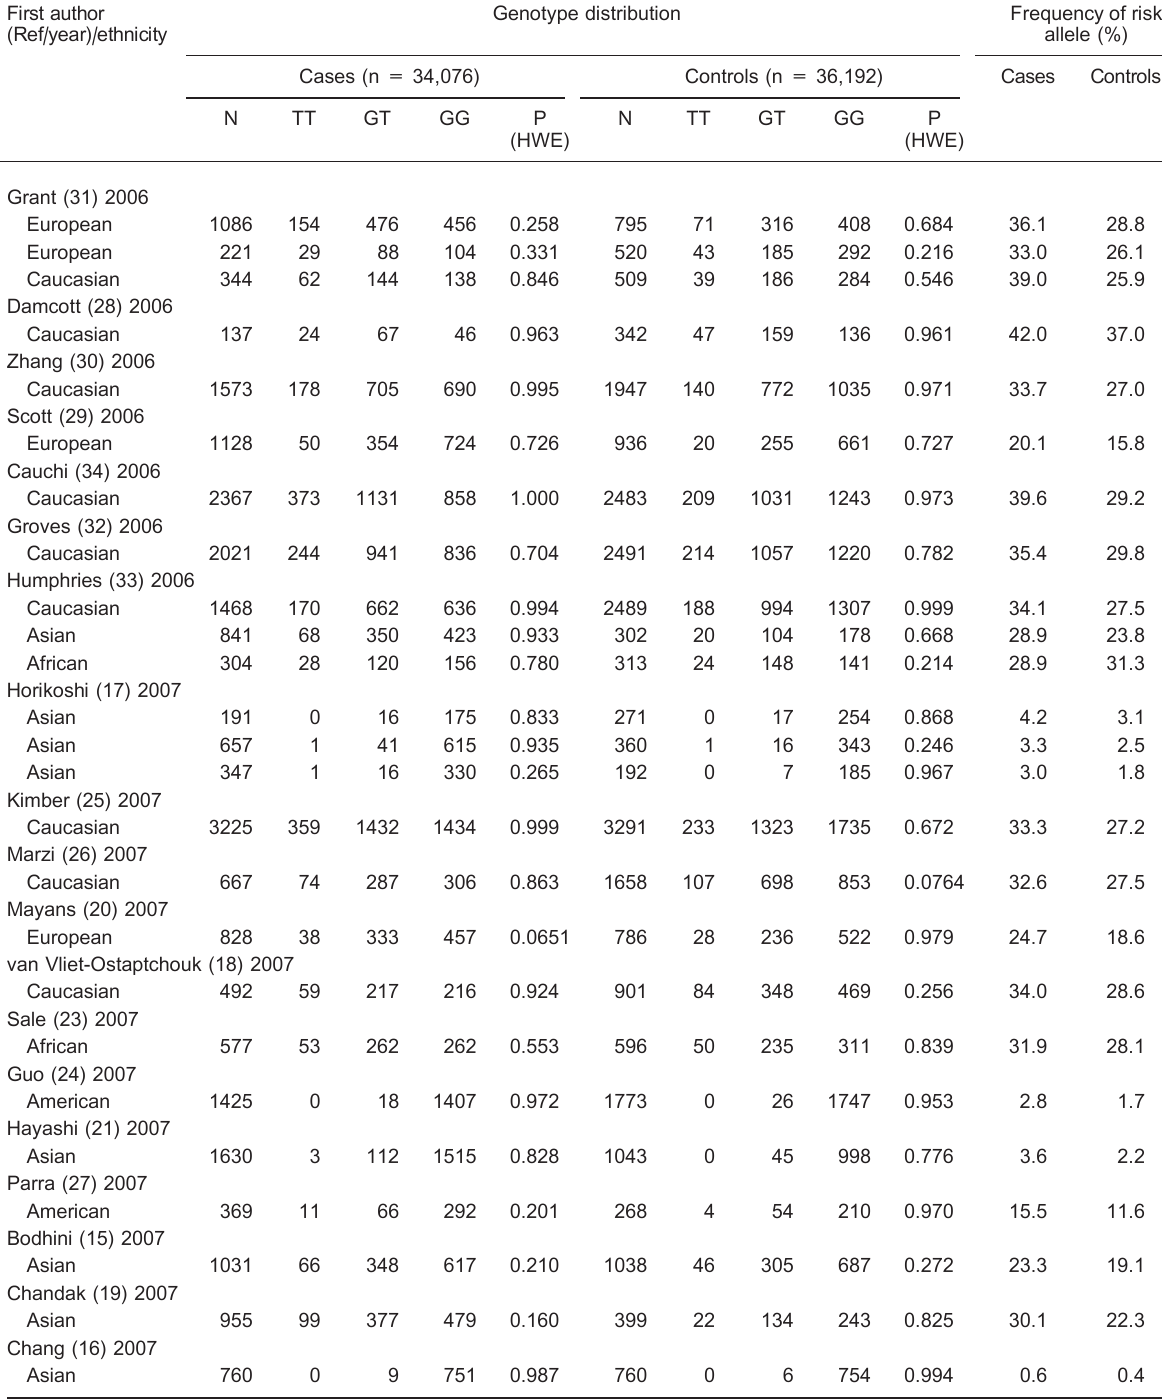
Table 1. Distribution of genotypes of the rs12255372 polymorphism in studies of the TCF7L2 gene and susceptibility to type 2